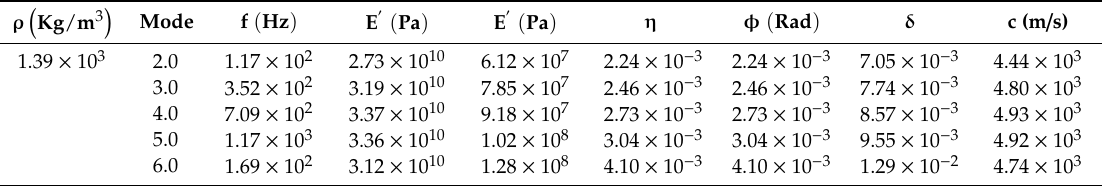
Table 2. Average values obtained for CFRE prepreg plates processed by autoclave.